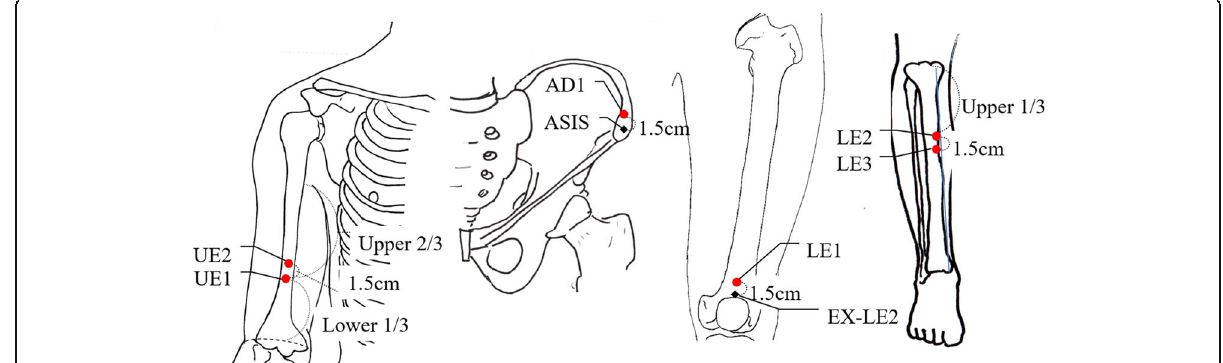
Fig. 3 Points used for Sham Acupuncture (SA). UE, upper extremity, AD, abdomen; ASIS, anterior-superior iliac spine; LE, lower extremity; EX-LE2, he